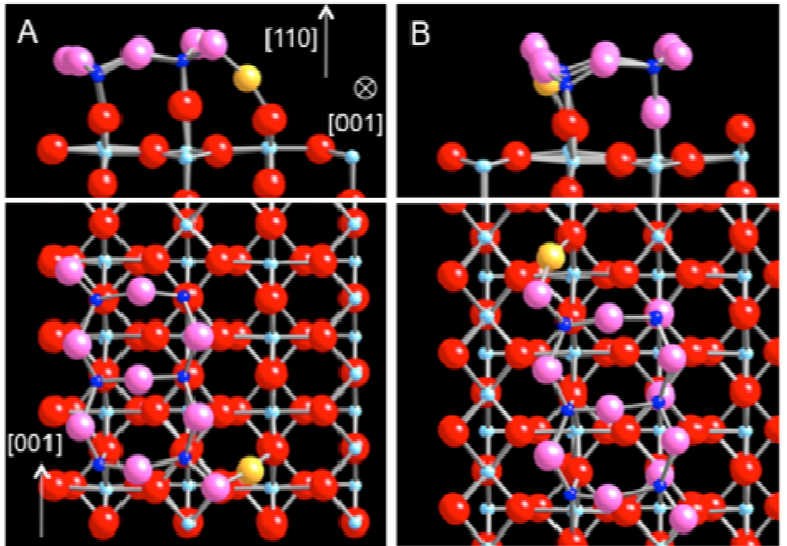
Figure 4. DFT-relaxed structures of Au adsorbed on the dot defect, modeled as (TiO TiO (110). ( a ) The energetically most favorable site and ( b ) the alternative 1-coordinated 2 O site. At both locations, Au is found between the 1c-O of the defect and the 2c-O of the surface. Au becomes anionic, losing electrons to the oxygen atoms of low coordination (defect Ti: dark blue; defect O: